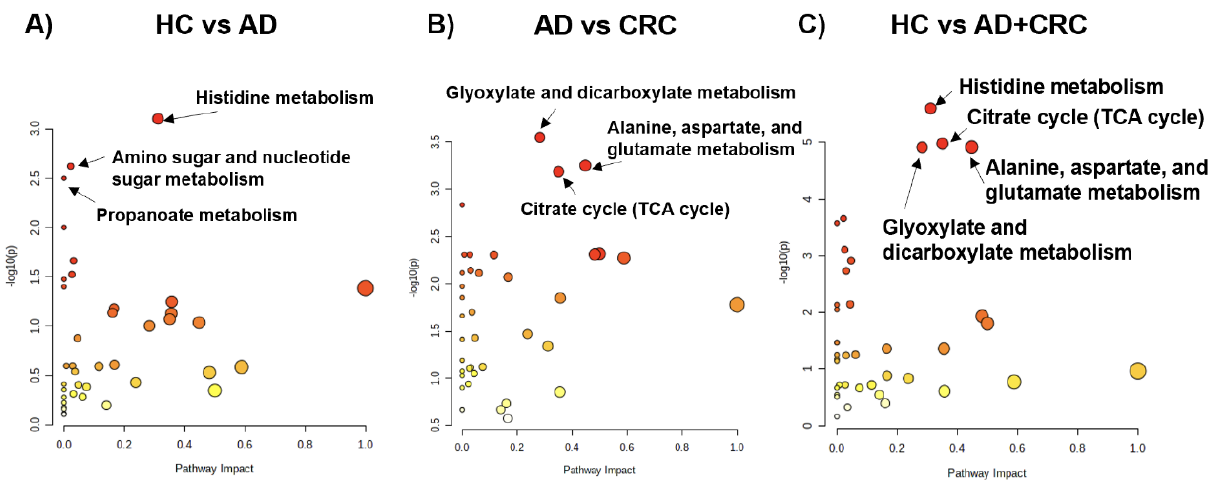
Figure 3. PLS-DA using integrated datasets (data 1 and data 2). ( A ) Score plots and ( B ) VID score. The frequently detected metabolites ( ≥ 50% of samples) showing significant differences among HC, AD, and CRC ( p < 0.05, Kruskal–Wallis test) were used, and the “normalization by sum” and “auto- scaling” options were used. The R2 and Q2 using 10-fold cross-validation were 0.409 and 0.307, respectively, using the two components.